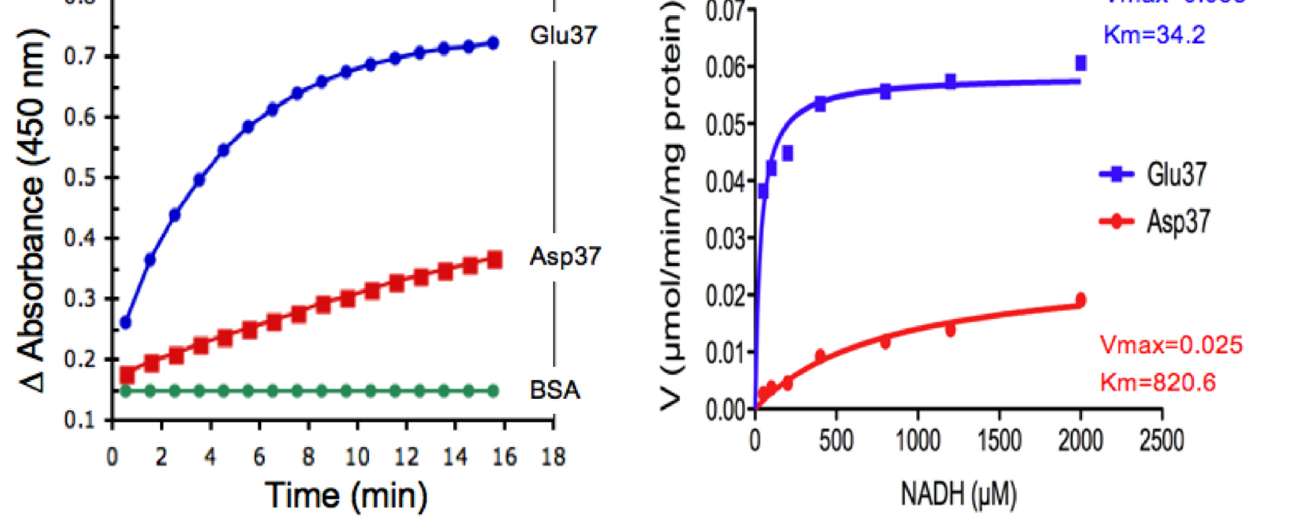
Figure 2. Enzymatic activity and kinetics parameters of renalase variants. Change in absorbance reflects the rate of WST-1 reduction, which is index of NADH oxidation; Glu37: glutamic acid at amino acid 37; Asp37: aspartic acid at amino acid 37; BSA, bovine serum albumin; raw data shown for a single experiment.